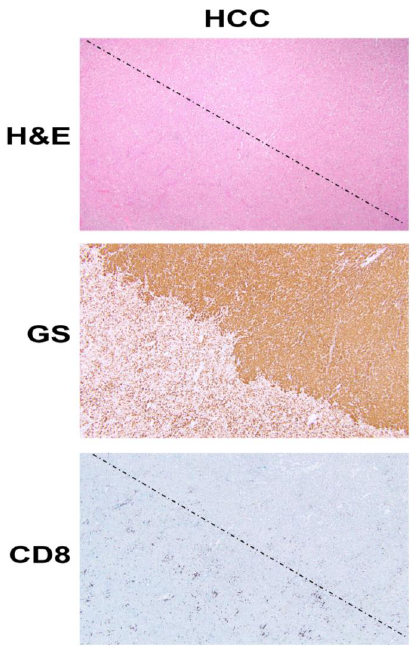
Figure 1. β-Catenin activation in HCC reduces CD8 T cell infiltration in the tumor . The top panel shows histology of explanted liver for hepatocellular cancer (HCC) showing the presence of two distinct tumors (separated by a dotted line) which are otherwise difficult to distinguish and demarcate by hematoxylin and eosin (H&E) staining (100×). The middle panel shows the immunohistochemistry of the adjacent tissue section to the top panel, for glutamine synthetase (GS), a surrogate marker of β-catenin activation due to mutations in CTNNB1 . The staining for GS shows the presence of uniform positive staining in the upper-right part which decorates a β- catenin-active HCC, whereas the lower-left tumor is negative for this stain. Immunohistochemistry for CD8 for a subset of T cells, in the section adjacent to those shown in the top and middle panels, shows a general dearth of positive cells in the top-right (β-catenin-active) tumor, while there are notably more CD8-positive cells in the lower left or in the non-β-catenin- active HCC. The two tumors are separated by a dotted line. One additional relevant mechanism in the liver might be through a known interaction of β-catenin with NF-κB in the hepatocytes and liver tumor cells [96]. This inhibitory association between the p65 subunit of NF-κB and β-catenin prevents NF-κB activation even when appropriate upstream effectors of NF-κB are present. In this study, we also showed that this association led to reduced p65-luciferase reporter activity when constitutively active β-catenin was transfected in hepatoma cells. Furthermore, β-catenin mutated HCCs showed decreased p65 nuclear translocation. Knowing that NF-κB signaling plays a major role in inducing inflammatory milieu [97], its suppression brought about by stable β-catenin due to mutations in CTNNB1 may be one additional contributor of an immune-deficient tumor microenvironment which may in turn lead to resistance to ICIs.